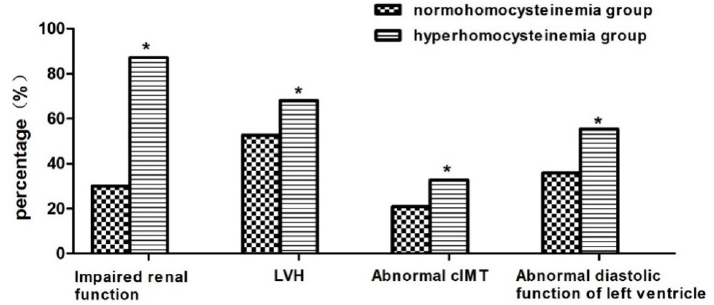
Figure 2. Comparison of target organ damage in patients with or without hyperhomocysteinemia. * Comparison with the normohomocysteinemia group, p < 0.05. cIMT, carotid intima-media thickness; LVH, left ventricular hypertrophy.